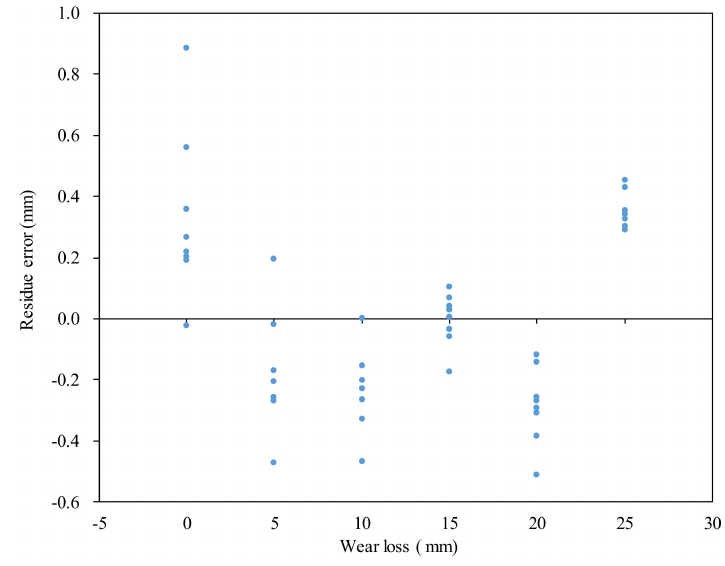
Figure 11. The residue errors after the linear relationship